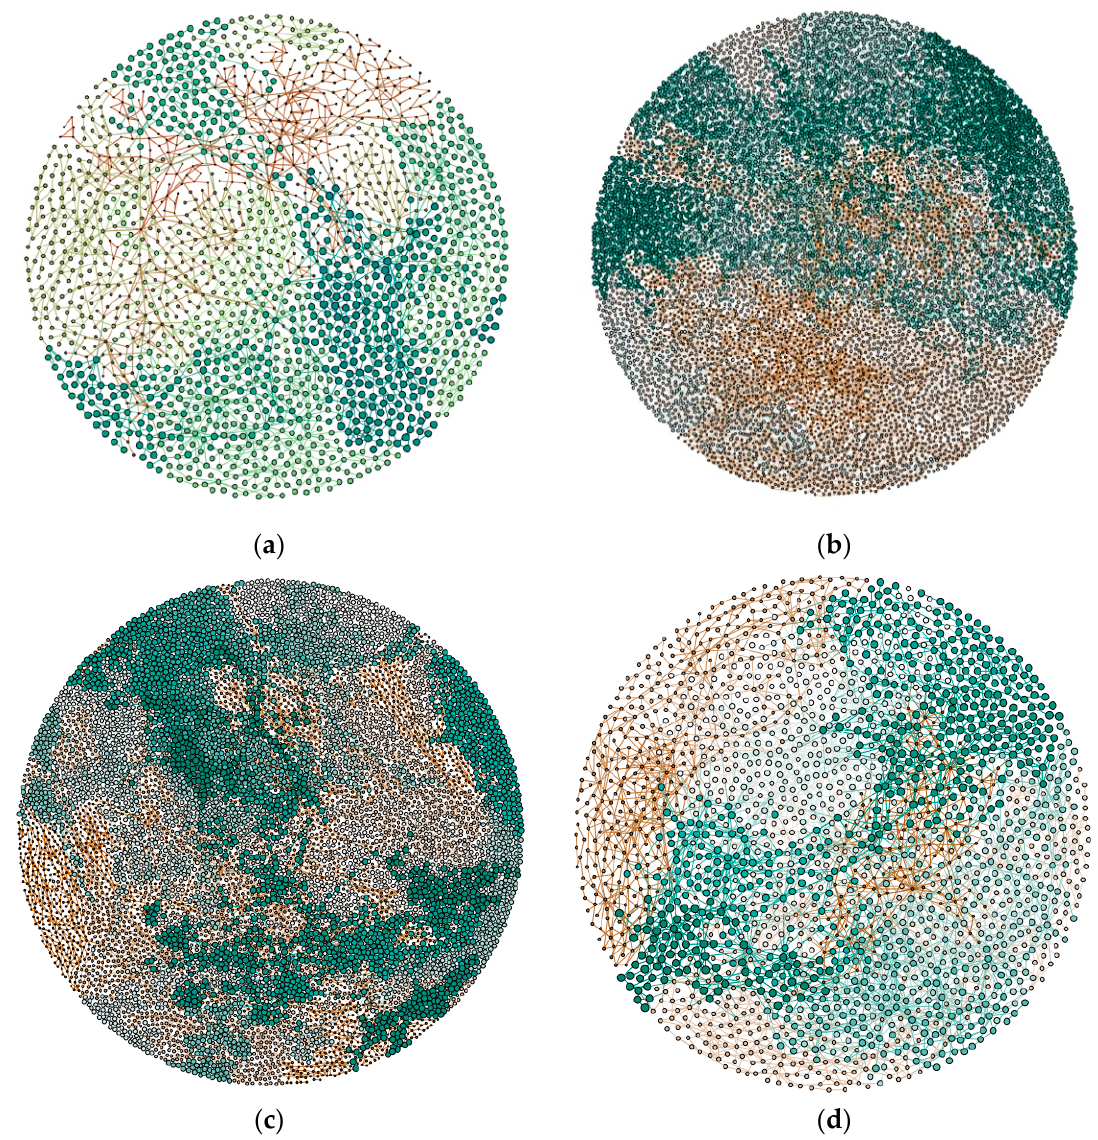
Figure 4. Association structure of sandstone pore network: ( a ) 14.1%; ( b ) 16.9%; ( c ) 17.1%;( d ) 24.6%.